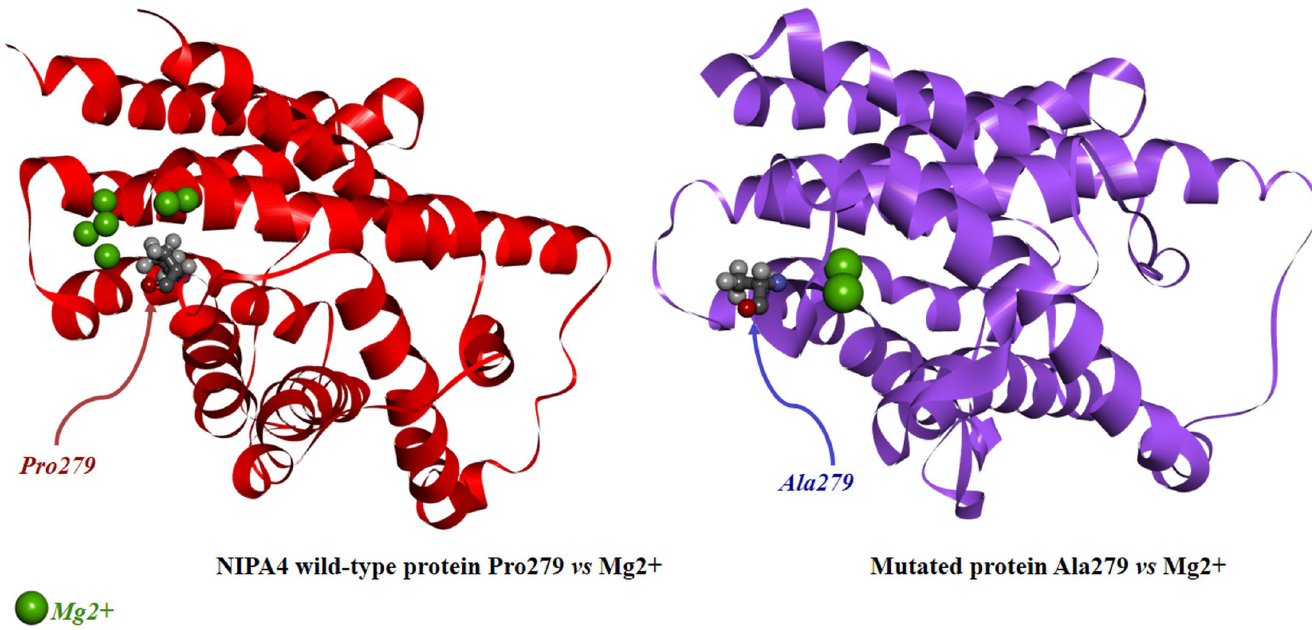
Fig 4. Docking analysis of the wild-type and the mutated p.(Pro279Ala) NIPA4 proteins against Mg 2+ .